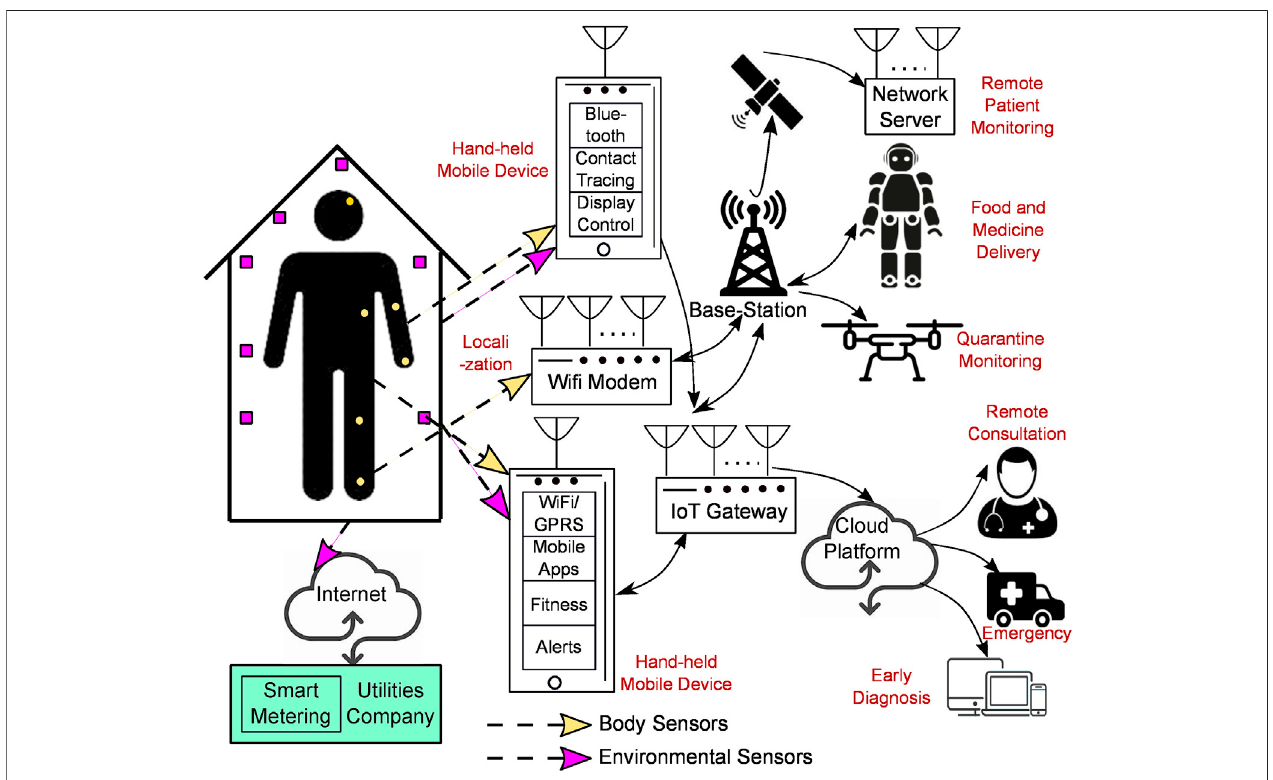
FIGURE 3 | Envisioned end-to-end IoT